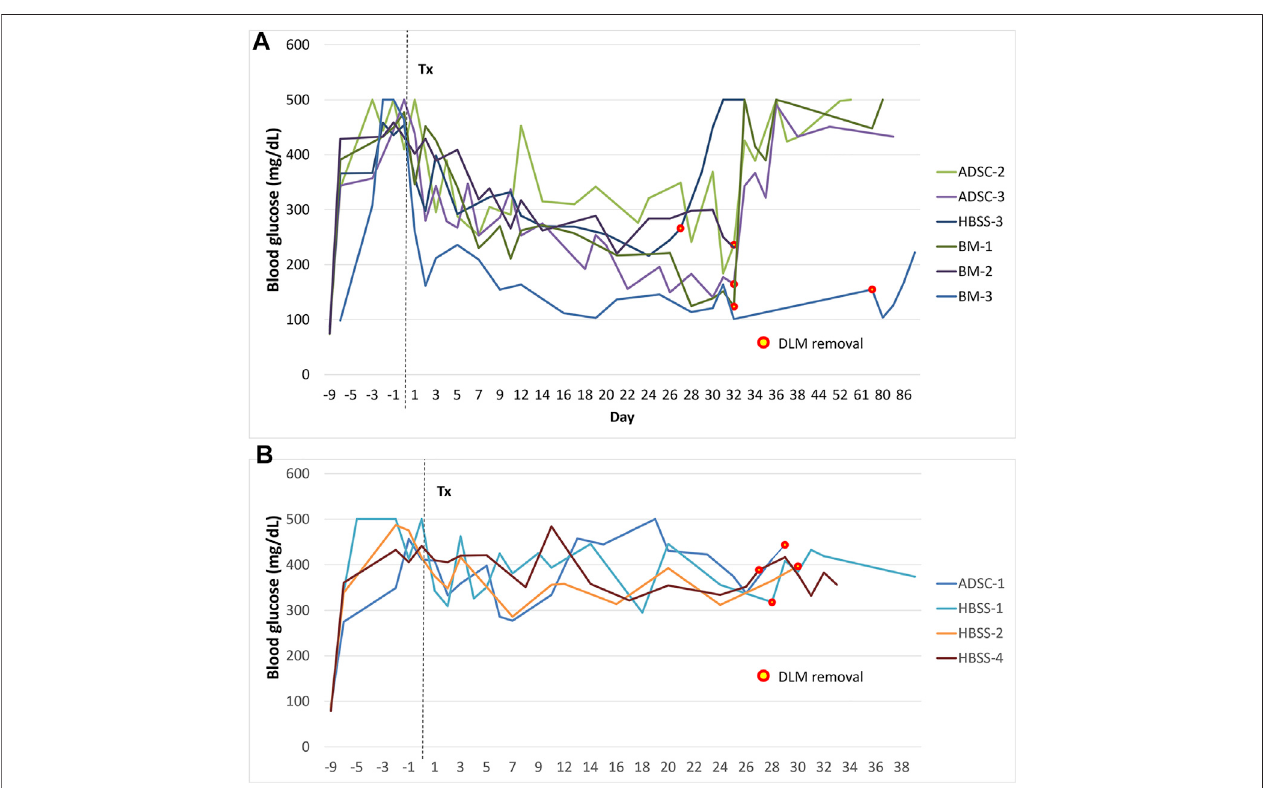
FIGURE 6 | Blood glucose levels during follow-up after transplantation. (A) animals with improvement of blood glucose levels, (B) animals that did not show improvement ofblood glucose levels. Themark signi fi esthetime ofgraftremoval. *The graftwasremoved after 81days inthe fi rstrat ofthestudytocheck forlong-term adverse effects (BM group, this graft was not included in histological or vascularization